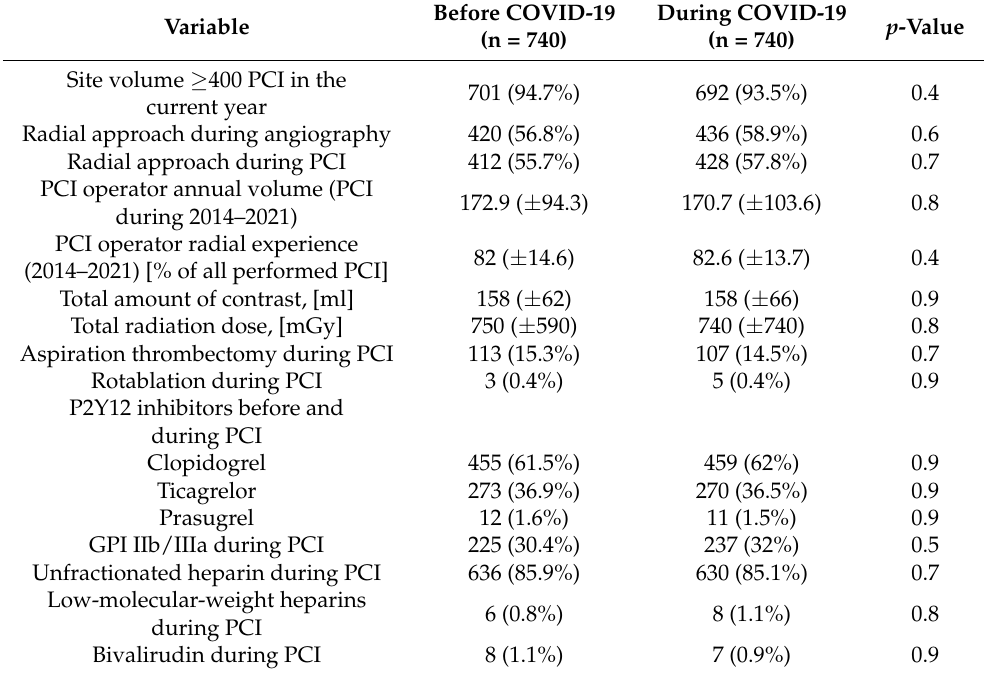
Table 3. Percutaneous coronary intervention details after propensity match